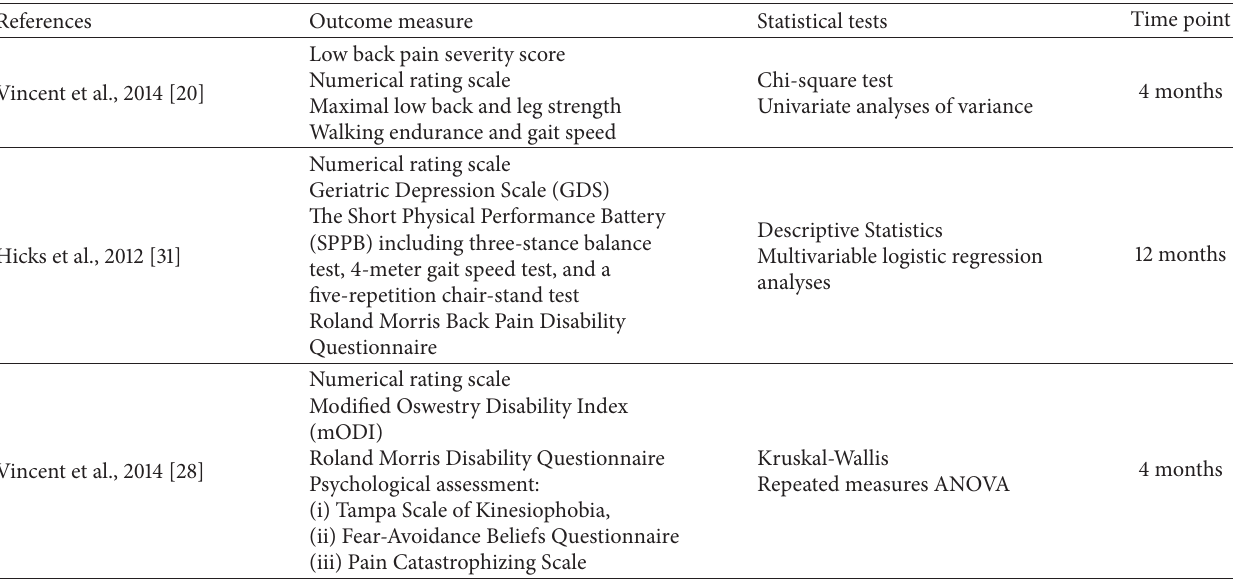
Table 5: Outcome measure and time